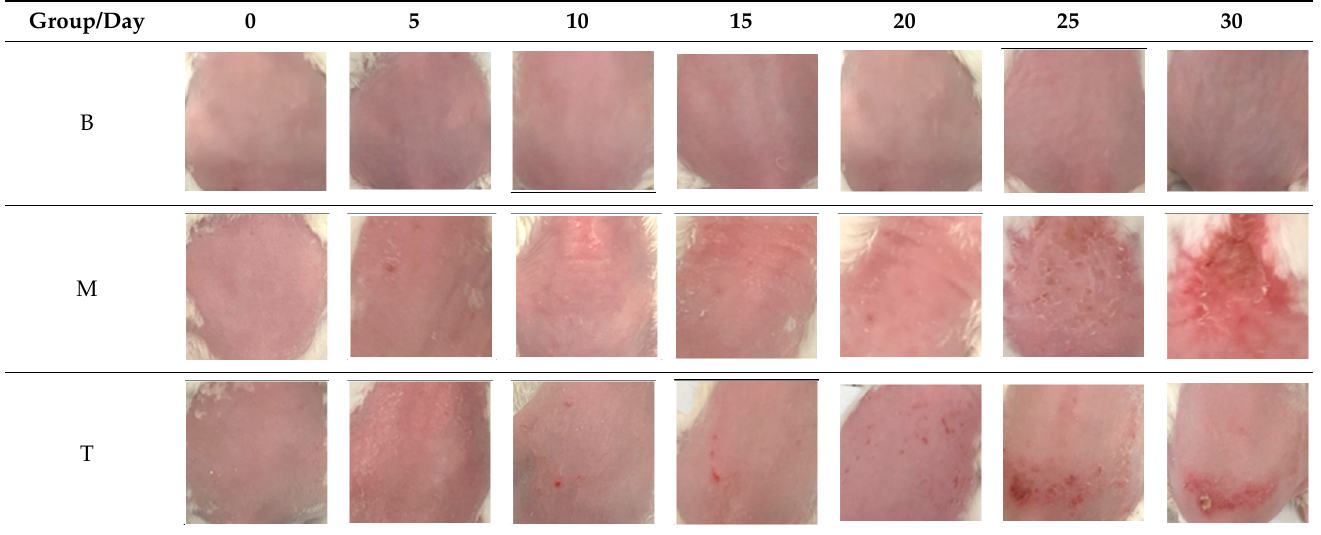
Table 3. Skin appearance evaluation standard of mice.